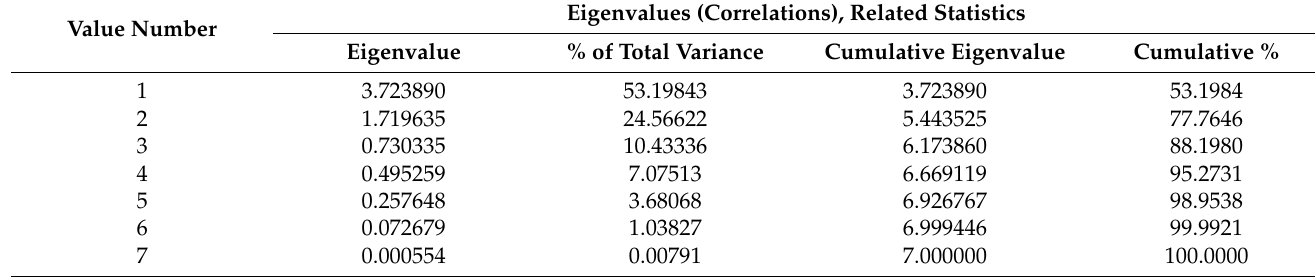
Table 7. Individual values of the correlation matrix.